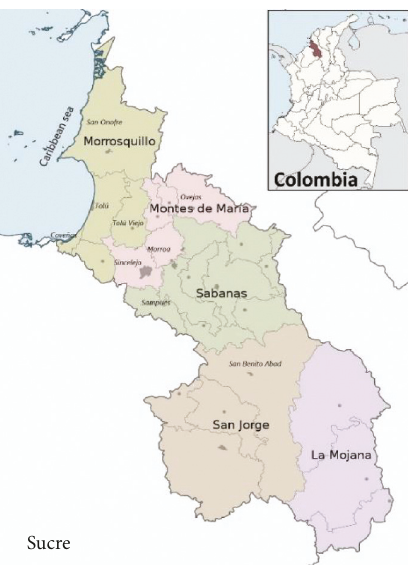
Figure 1: Location of the Department of Sucre,